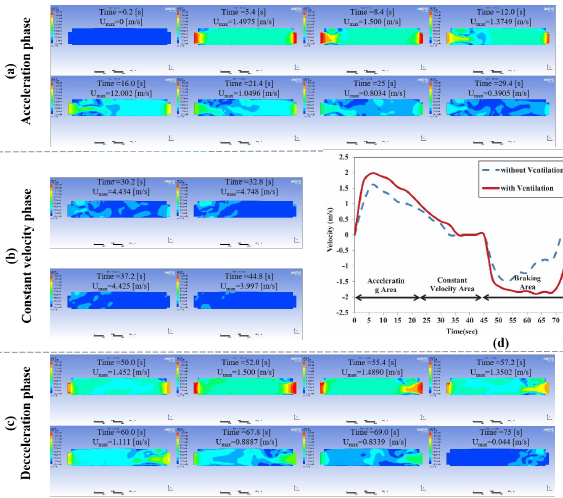
. Figure 5 . Velocity contour map of interior induced flow in the XZ section. (time-interval is 0.2s but sampling is random)